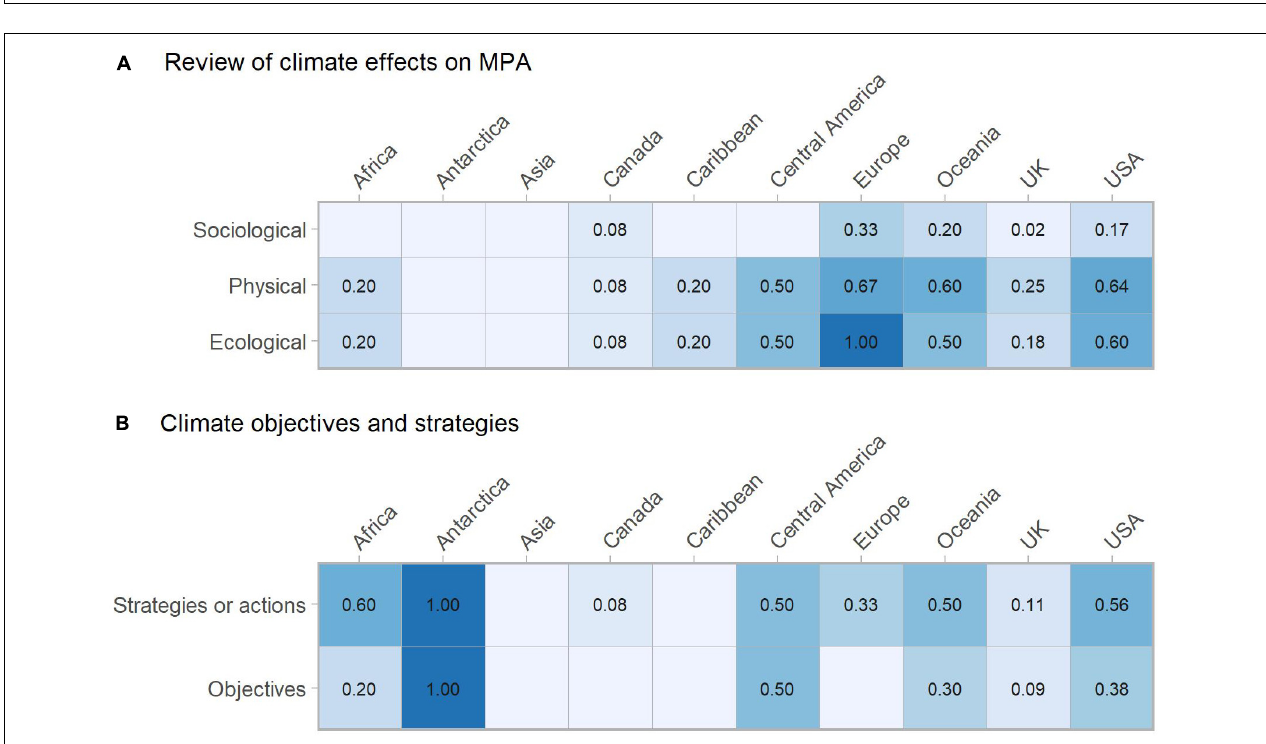
FIGURE 3 | The proportion of climate-considering MPA management plans in each region that contained the (A) ecological, (B) physical, or (C) sociological component terms.